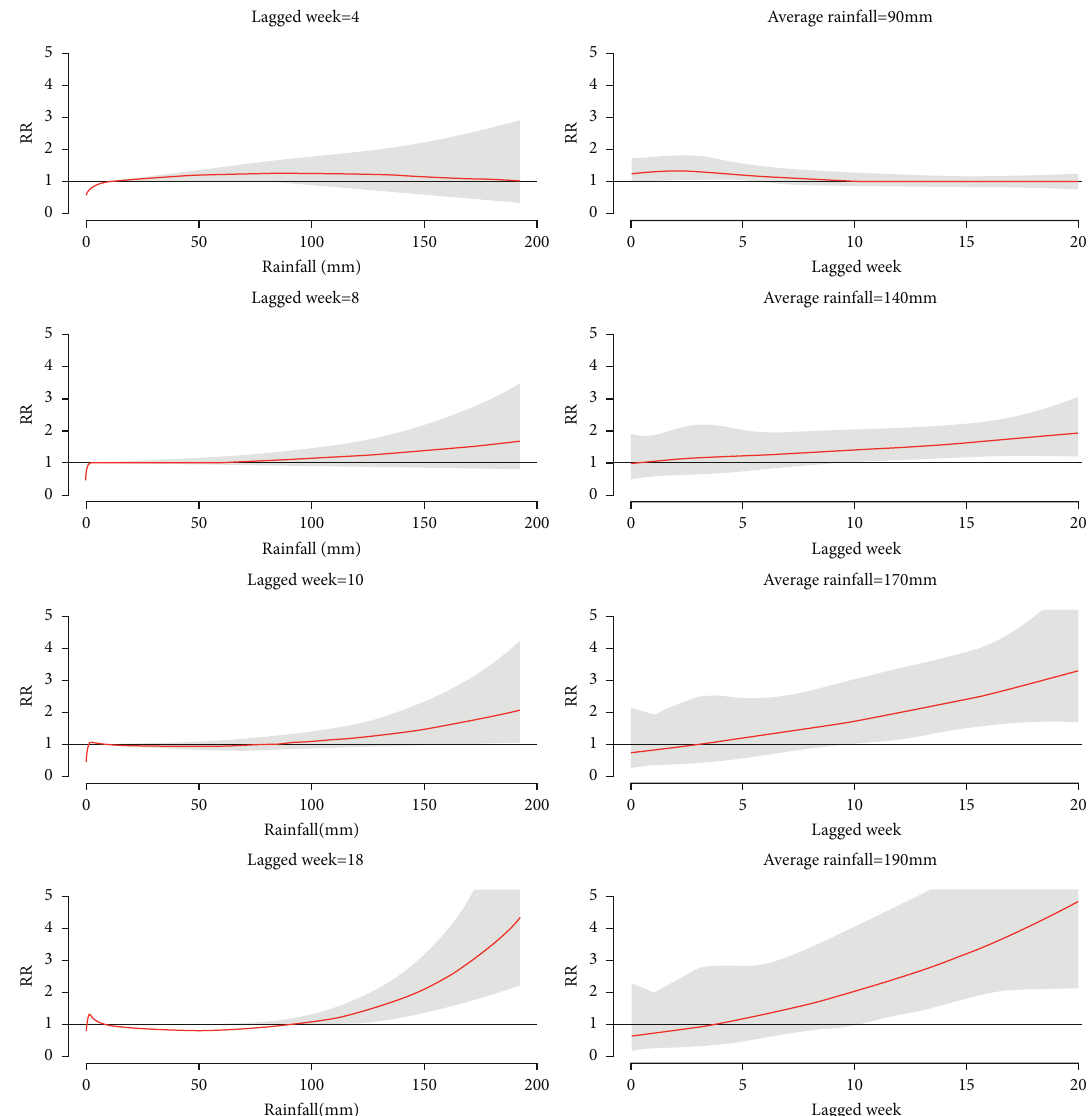
Figure 5: Relative risk of dengue fever associated with rainfall at selected lagged weeks (a) and lagged weeks with respect to selected rainfall (b). The shaded region indicates 95% confidence